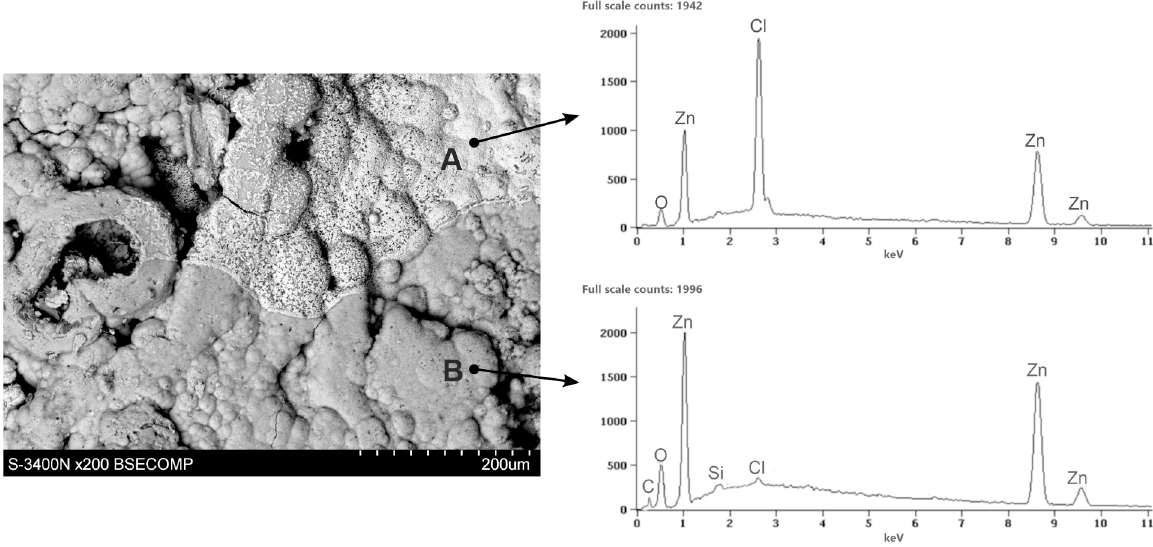
Figure 7. SEM images and corresponding EDS patterns of the corroded ZAMS coating surface after 1000 h exposure in the NSS test.